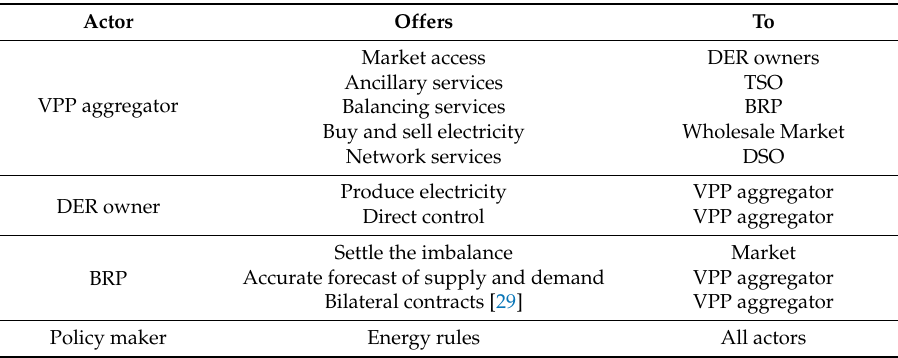
Table 2. Actors in Virtual Power Plants (VPPs).